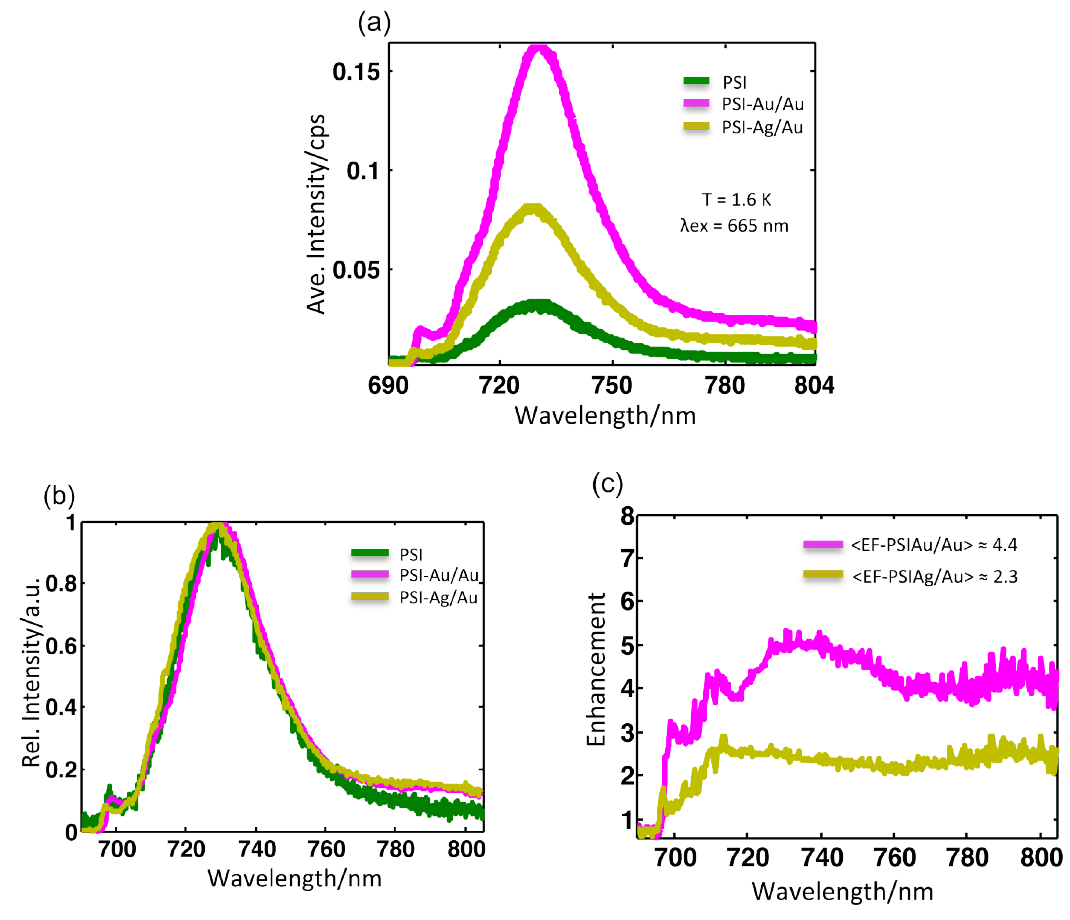
( a ) Average fluorescence spectra of all samples after baseline correction at T = 1.6 K upon excitation at 665 nm. The accumulation time for PSI-glass was 2 s, while for PSI-Au/Au and PSI-Ag/Au, it was 1 s. ( b ) The normalized average spectra were scaled to the same maximum value after baseline correction. No pronounced broadening in the linewidth of any sample was found. ( c ) Wavelength-dependent enhancement spectra obtained after dividing the average spectra of PSI-Au/Au and PSI-Ag/Au by the average spectrum of PSI-glass. More enhancement was observed around main peak region (730 nm) and in the far red region ( > 780